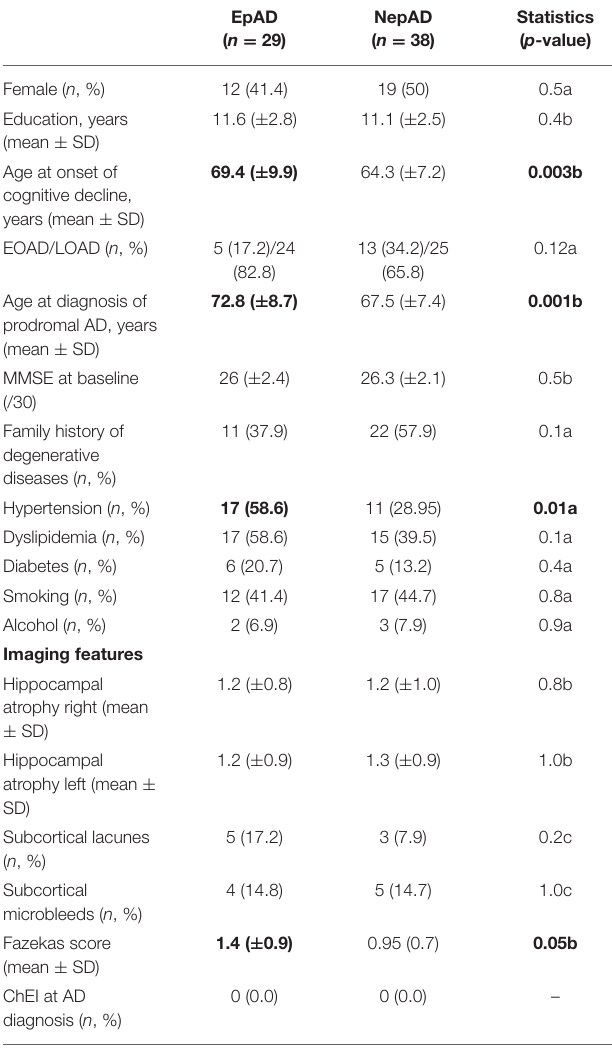
TABLE 1 | Patients’ clinical and radiological